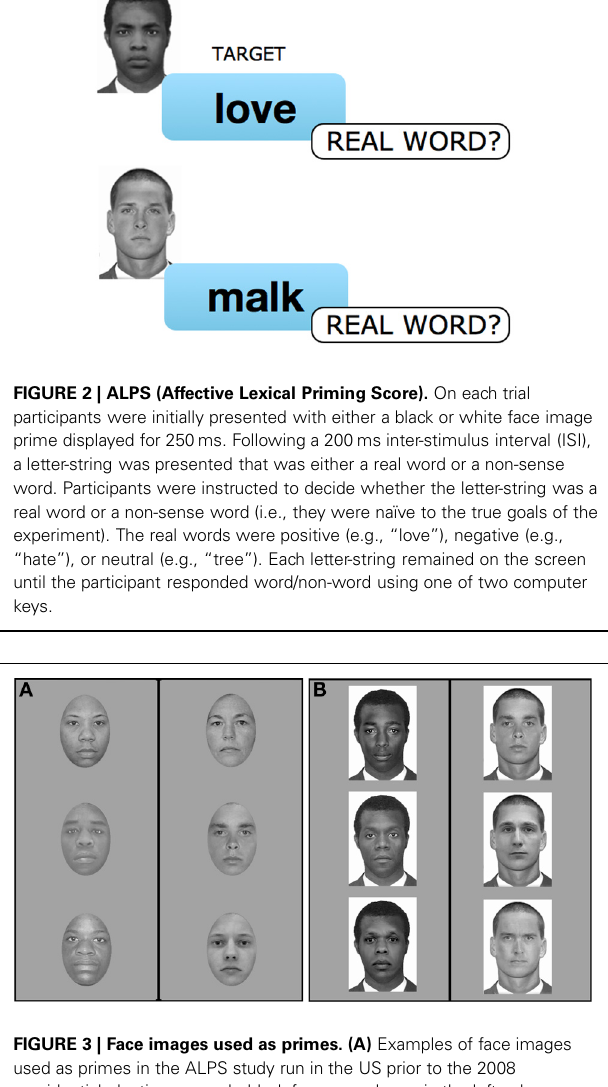
third party checked to ensure they were: (a) pronounceable;